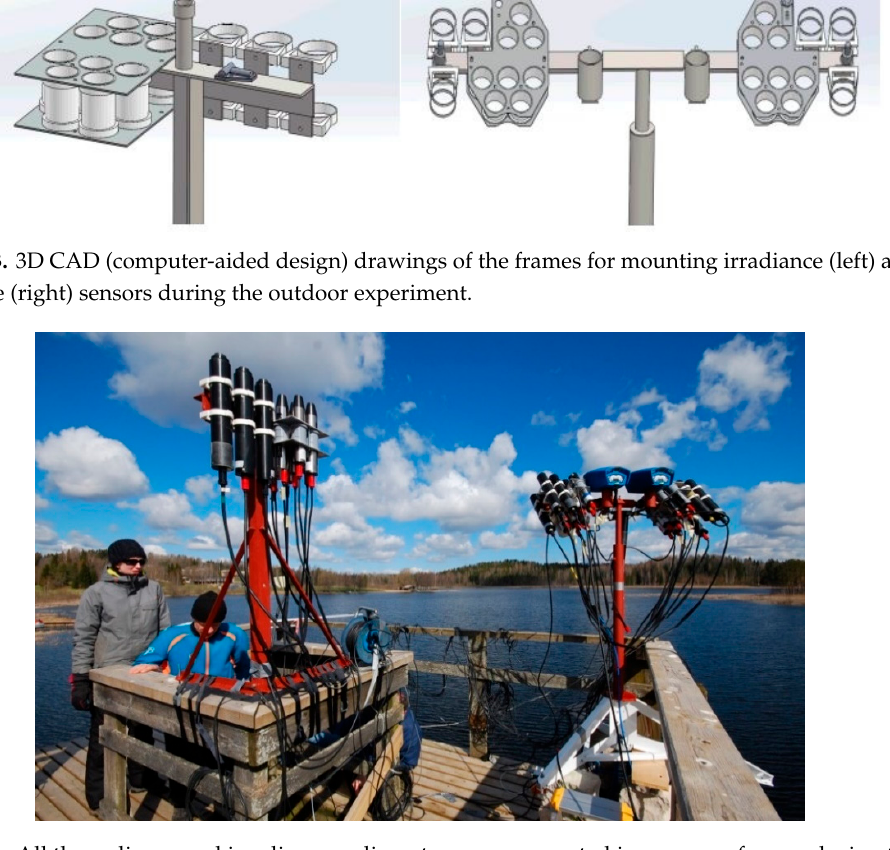
Figure 4. All the radiance and irradiance radiometers were mounted in common frames during the LCE-2 outdoor experiment. Left frame—irradiance sensors; right frame—radiance sensors.